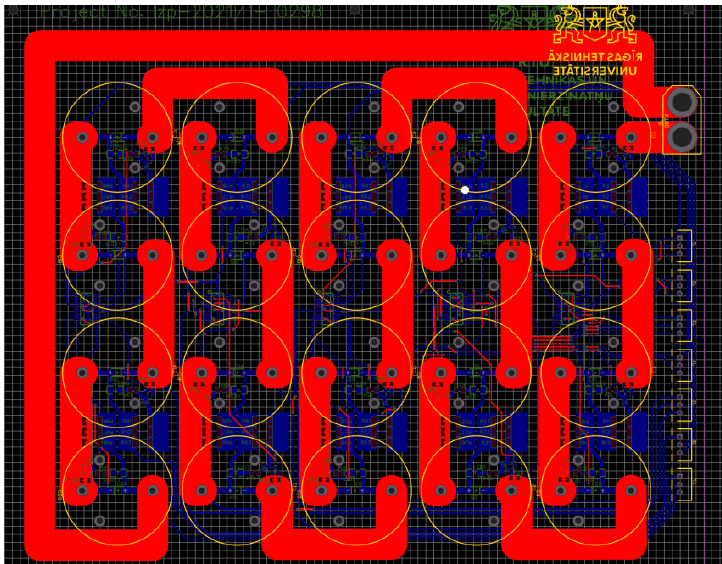
Figure 39. SC circuit board conducive traces (red).